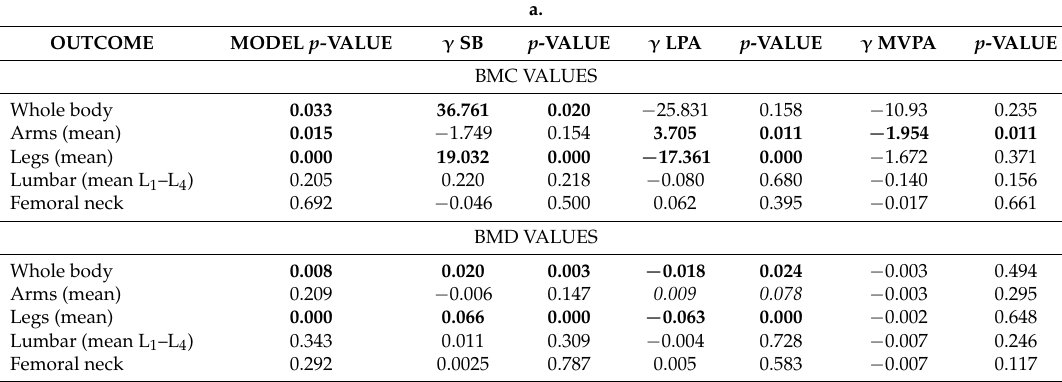
Table 4. Compositional behavior model for bone mass variables for the proportion of the waking hours